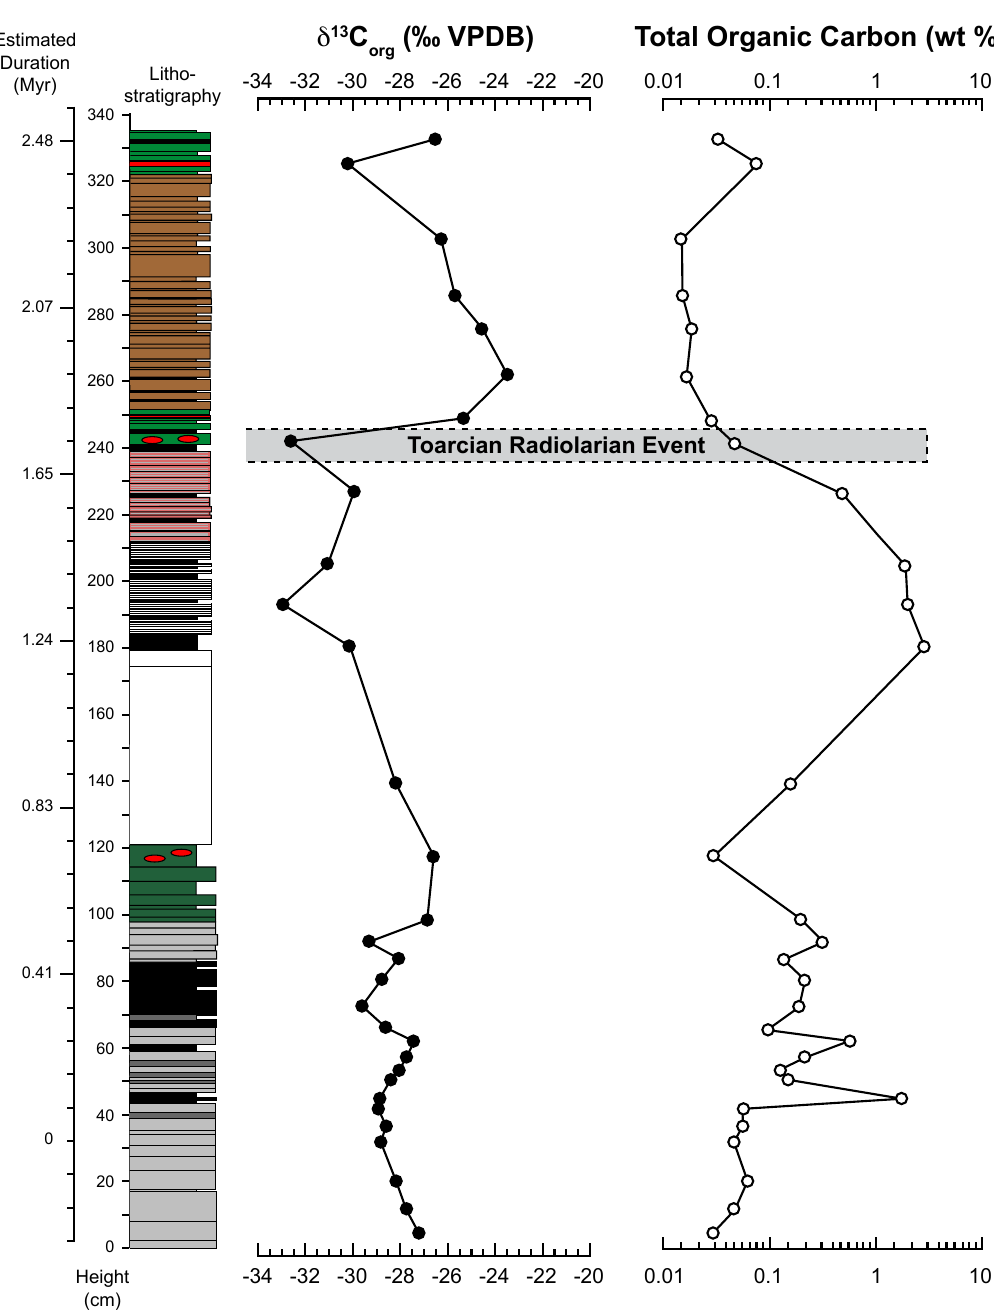
Fig. 5. Organic carbon isotope record ( δ 13 C org ) of the Katsuyama section, Inuyama, Japan. Total organic carbon (TOC) as weight percent (wt%) was determined during stable isotope measurements. Note that the scale for TOC is logarithmic. The chert sample at ca. 212cm has a δ 13 C org value of − 57‰: whilst this value has been replicated, it is possible that this particular sample is somehow contaminated. The Toarcian Radiolarian Event is also depicted at ca. 240cm. See Fig. 3 for lithostratigraphic and biostratigraphic